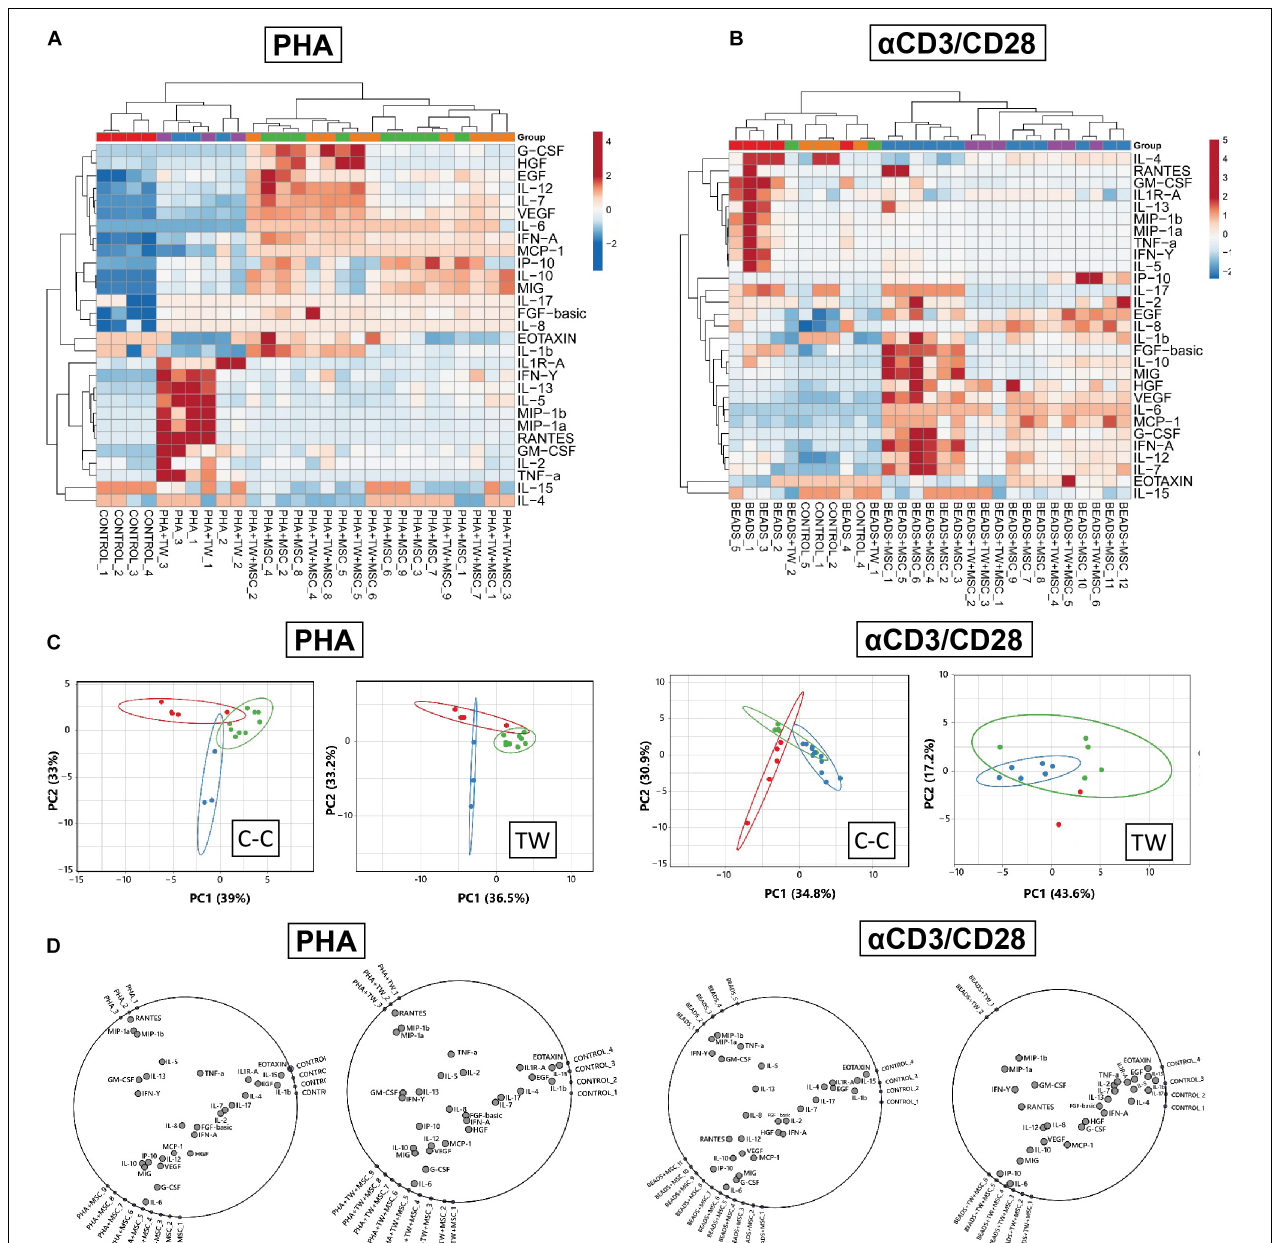
FIGURE 2 | Characterization of immune modulatory secretome in UC-MSC/PBMNC cocultures. Global differences in cytokine concentrations in supernatants from UC-MSC/PBMNC as compared to activated and resting PBMNC in cell-contact and transwell experimental settings were visualized by unsupervised hierarchical clustering in (A) PHA-stimulated and (B) α CD3/CD28-stimulated UC-MSC/PBMNC cocultures. (C) Two-dimensional Principal Component Analyses (PCA) was carried out to determine associations between expression patterns of analyzed factors in PHA and α CD3/CD28 cocultures. (D) Radial visualization (RadViz) analyses showing factors assigned to dimensional anchors placed on the circumference of each circle for PHA and α CD3/CD28 stimulations in cell contact and transwell formats.